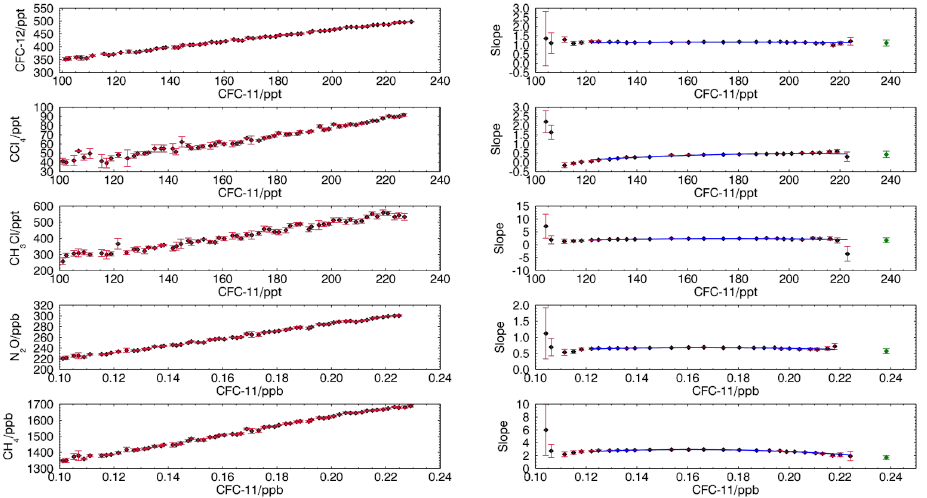
Figure B12 Correlations between the volume mixing ratios of CFC-12, CCl 4 , CH 4 , CH 3 Cl and N 2 O and CFC-11 for the data from the southern hemisphere during the stratospheric summer of 2007. Left panels: The mean correlation profile. Each point represents the mean of the VMR in a window of 2 ppt of CFC-11. The error on these points is the standard deviation of the data within each 2 ppt window. Right panels: The local slope of data in an 80 ppt of CFC-11 window. The error on the points is the fitting error of this fit. The blue line is a second degree polynomial fit to the local slopes. The green point is the extrapolated slope at the tropopause.